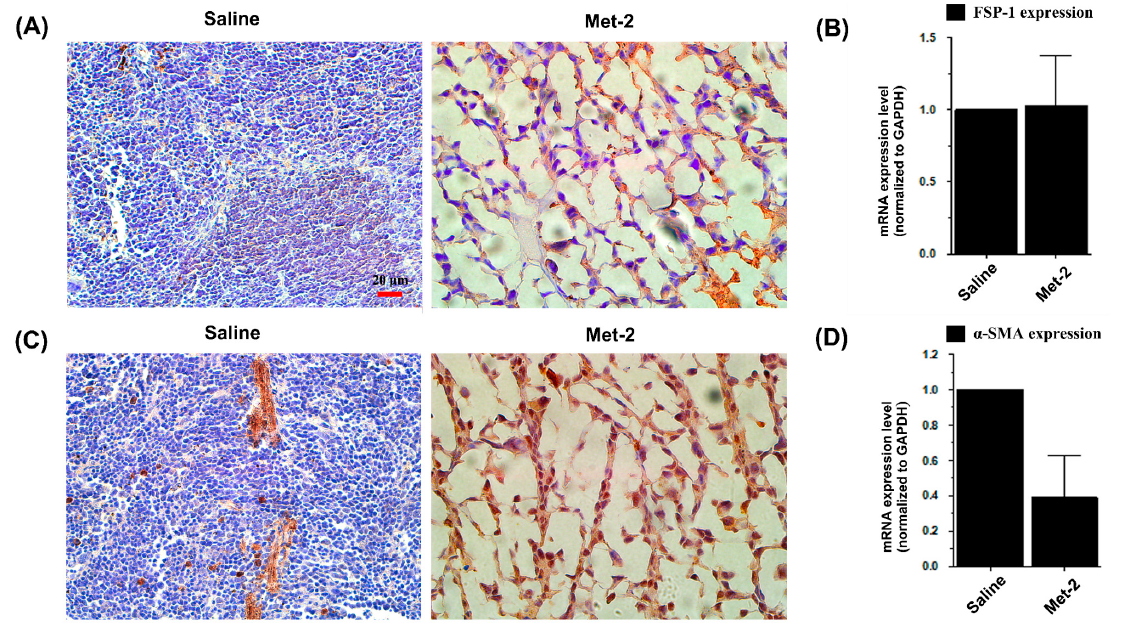
Figure 9. Effect of metronomic cyclophosphamide on tumor-associated fibroblasts (TAFs). ( A ) Immunohistochemistry of FSP-1 in the tumor microenvironment, scale bar = 20 μ m. ( B ) qPCR analysis for the mRNA level of FSP-1 in the tumor microenvironment. ( C ) Immunohistochemistry of α -SMA in the tumor microenvironment α -SMA, scale bar = 20 μ m. ( D ) qPCR analysis for the mRNA level of α -SMA in the tumor microenvironment. H&E staining was performed as indicated above. Tumors were collected and total RNA was isolated; then, qPCR was performed as previously described.